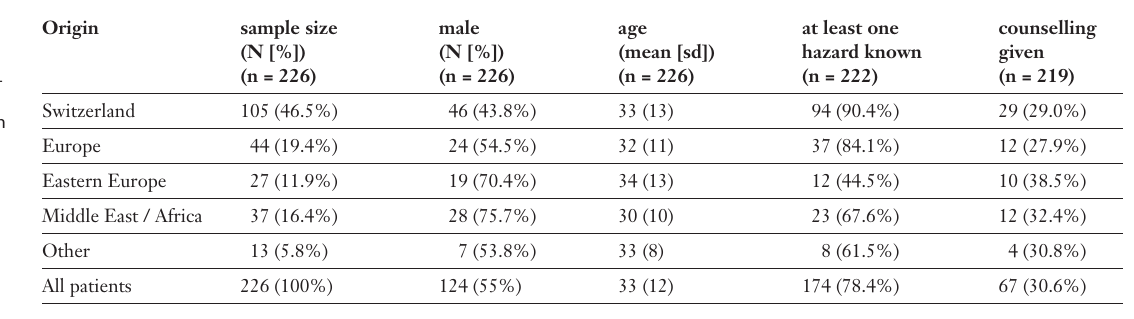
Univariate and multivariate analysis for ignorance of health hazard due to